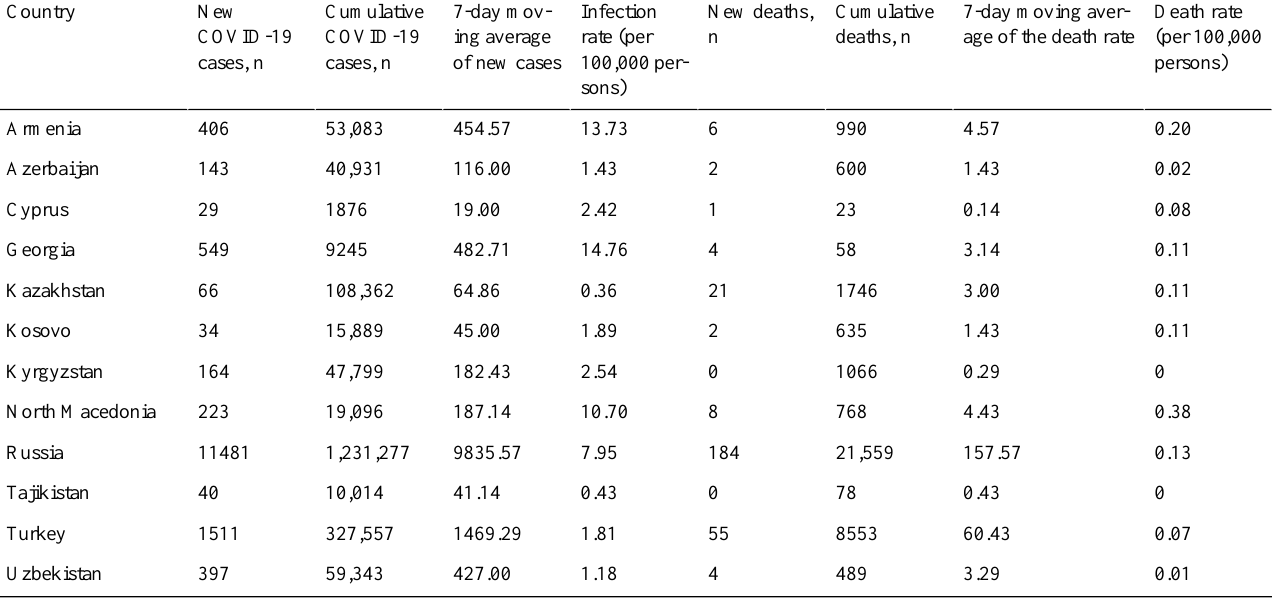
Table 2. Static surveillance metrics for the week of September 30 to October 6,